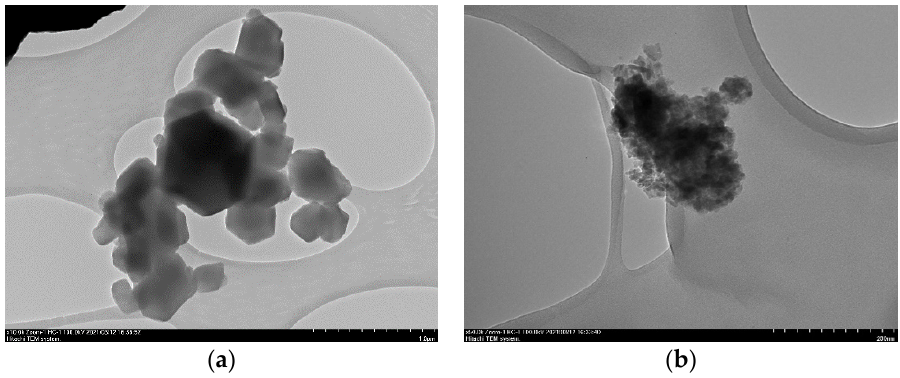
Figure 2. TEM images of 5mw ( a ) and 4mw ( b )